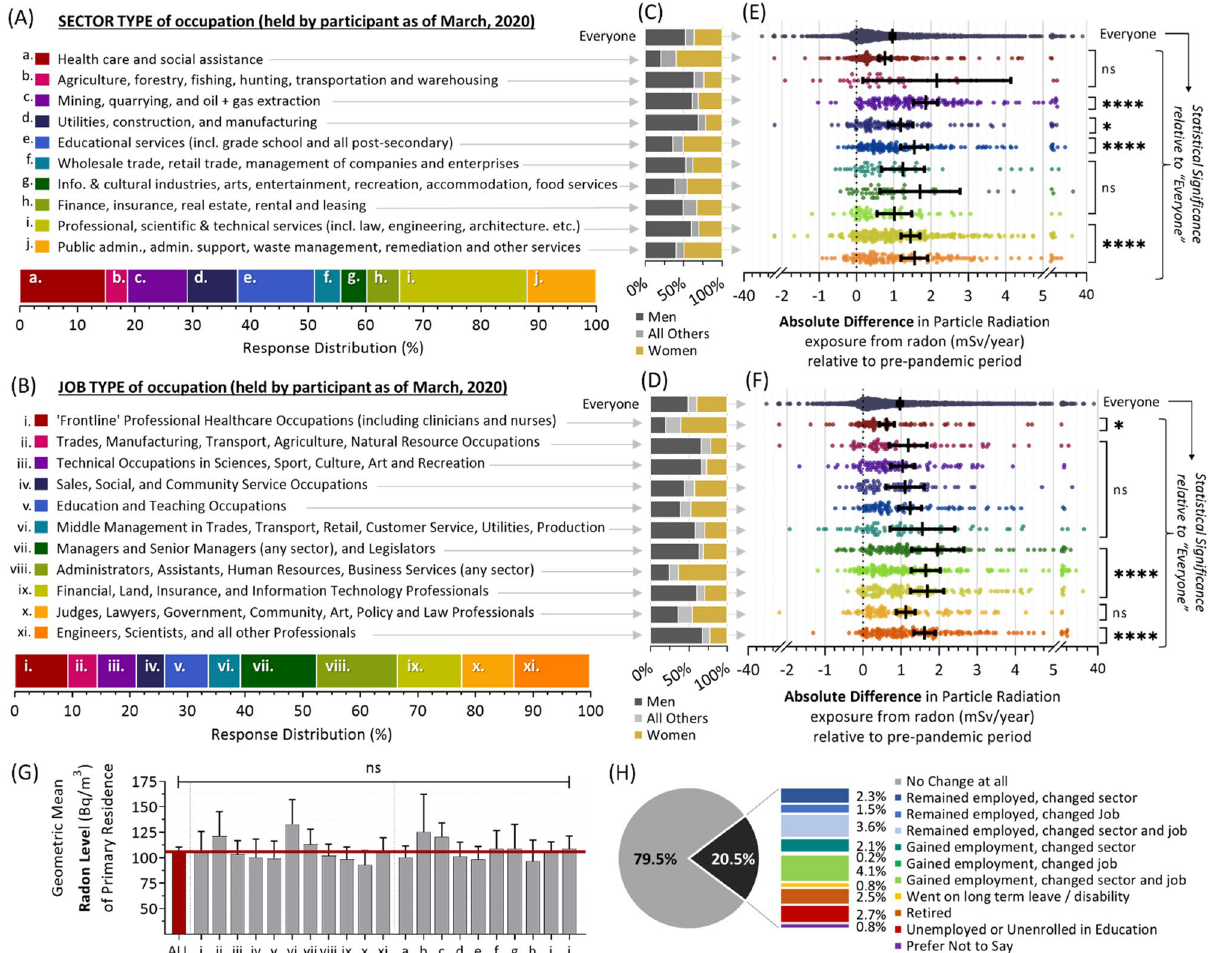
Figure 6. Increases in residential radon exposure after COVID-19 pandemic onset as a function of sector and job type. Panel A . Relative distributions of sectors of employment held by participants at the start of the COVID-19 pandemic in Canada (March 2020). Panel B . Relative distributions of job types performed by participants at the start of the pandemic. Panels C , D . Gender distributions associated with indicated sector and job types from ( A , B ). Please note, in this case, “all others” refers to the combination of gender minorities together with all those who did not report their gender identity. Panels E , F . The absolute difference in radiation dose rate (mSv/y) from residential radon relative to the pre-pandemic period as a function of sector ( E ) and job ( F ). Panel G . The geometric mean radon level of the primary residence in Bq/m 3 for all demographic groups indicated in ( E , F ). Panel H . Distribution of those experiencing a change in employment (or not) following the onset of the COVID-19 pandemic. For all data, pairwise statistical comparisons are Mann–Whitney tests, while larger demographic group comparisons are 1-way ANOVA. * p < 0.05, *** p < 0.001, **** p < 0.0001; ns = p > 0.05. Figures were prepared using Excel and GraphPad Prism 9.1.1 (225) (www. graph pad.